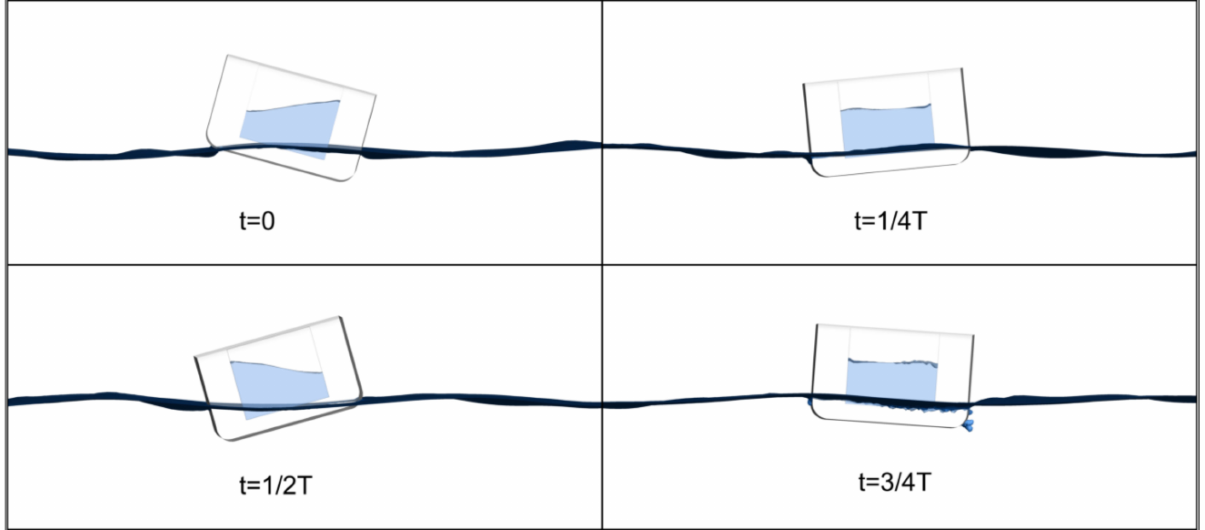
Figure 22. For the ship in beam waves at λ /L = 0.787 with the height of the liquid in the tank at 0.3 m, wave-induced ship positions and sloshing-induced surface elevations inside the tank at time steps of t = 0, t = 1/4 × T, t = 1/2 × T, and t = 3/4 × T. When the height of the liquid in the tank is 0.2 m, at time = 0, the ship rolls to the right while the internal sloshing flow heads upwards on the right side of the tank wall, while at time = 1/2 × T, the ship rolls to the right while the internal sloshing flow heads upwards on the left side of the tank wall. At time = 1/4 × T and 3/4 × T, the sloshing of the internal liquid is different from that in Figure